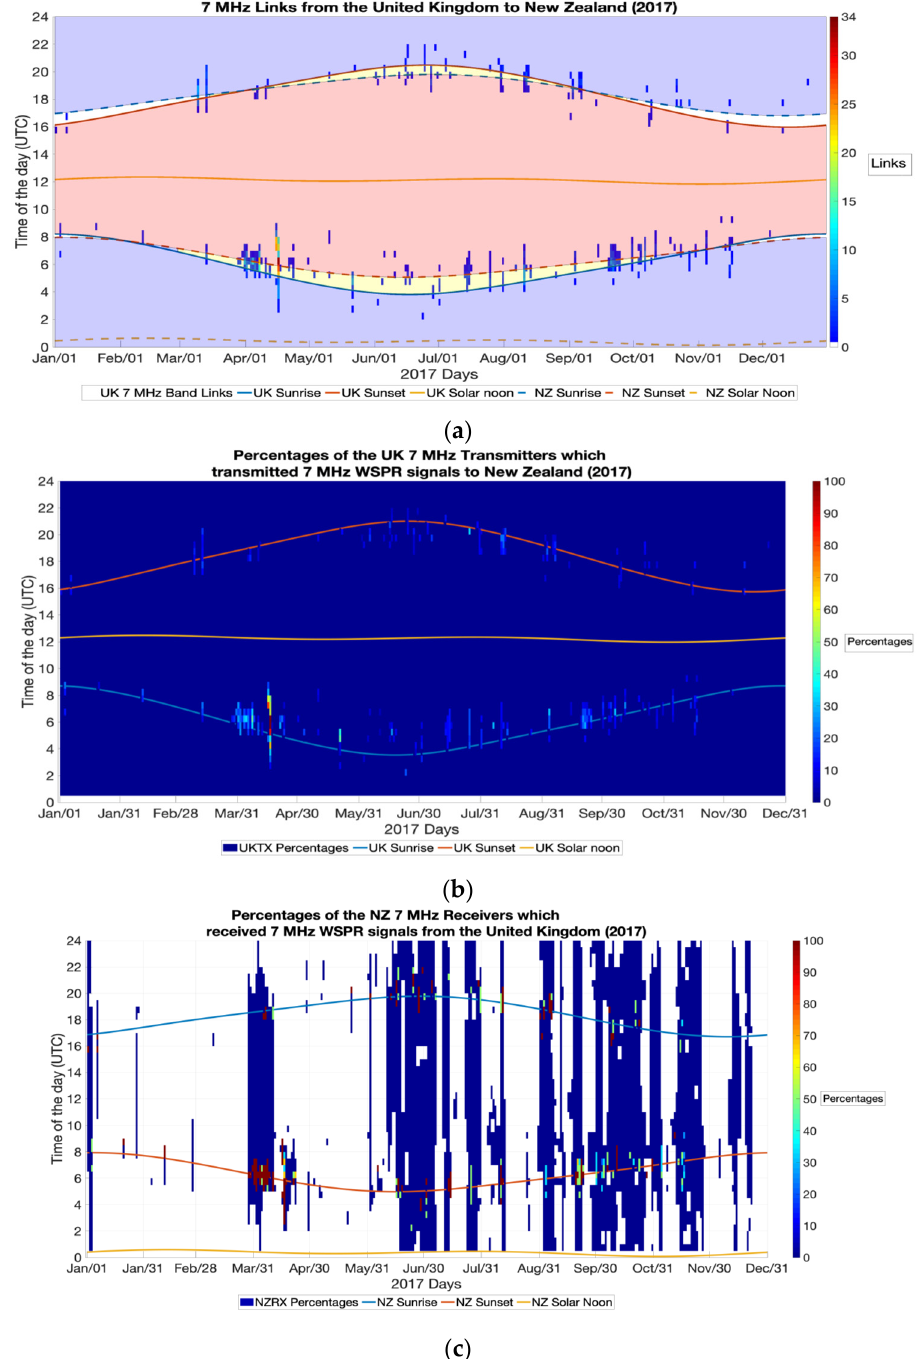
Figure 14. ( a ) The 7 MHz radio links made from the UK to New Zealand in 2017. The blue shaded area is the New Zealand daytime hours. The red area is the UK daytime hours. The yellow shaded area is the common daytime hours, and the white shaded area is the common night hours. The colours indicate the number of links available in each half-hour interval. ( b ) Percentages of active UK WSPR transmitters which have transmitted a link to New Zealand in 2017. Only transmitters with a proven capability to cover the distance from the UK to New Zealand are shown. The colours indicate the number of receivers available in each half-hour interval. ( c ) Percentages of active New Zealand WSPR receivers which have received a link from the UK in 2017. Only receivers with a proven capability to cover the distance from the UK to New Zealand are shown. The colours indicate the number of receivers available in each half-hour